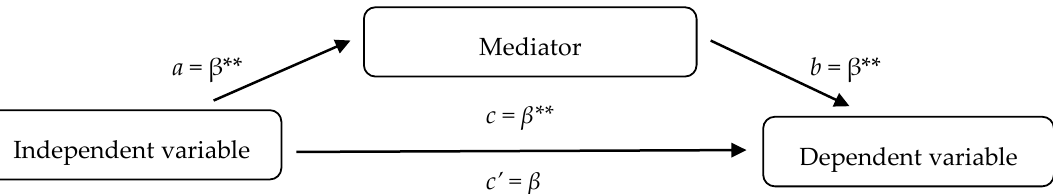
Figure 2. Theoretical model of the role of the mediator in the relationship between dimensions of temperament and dimensions of SOC; ** p < 0.01.